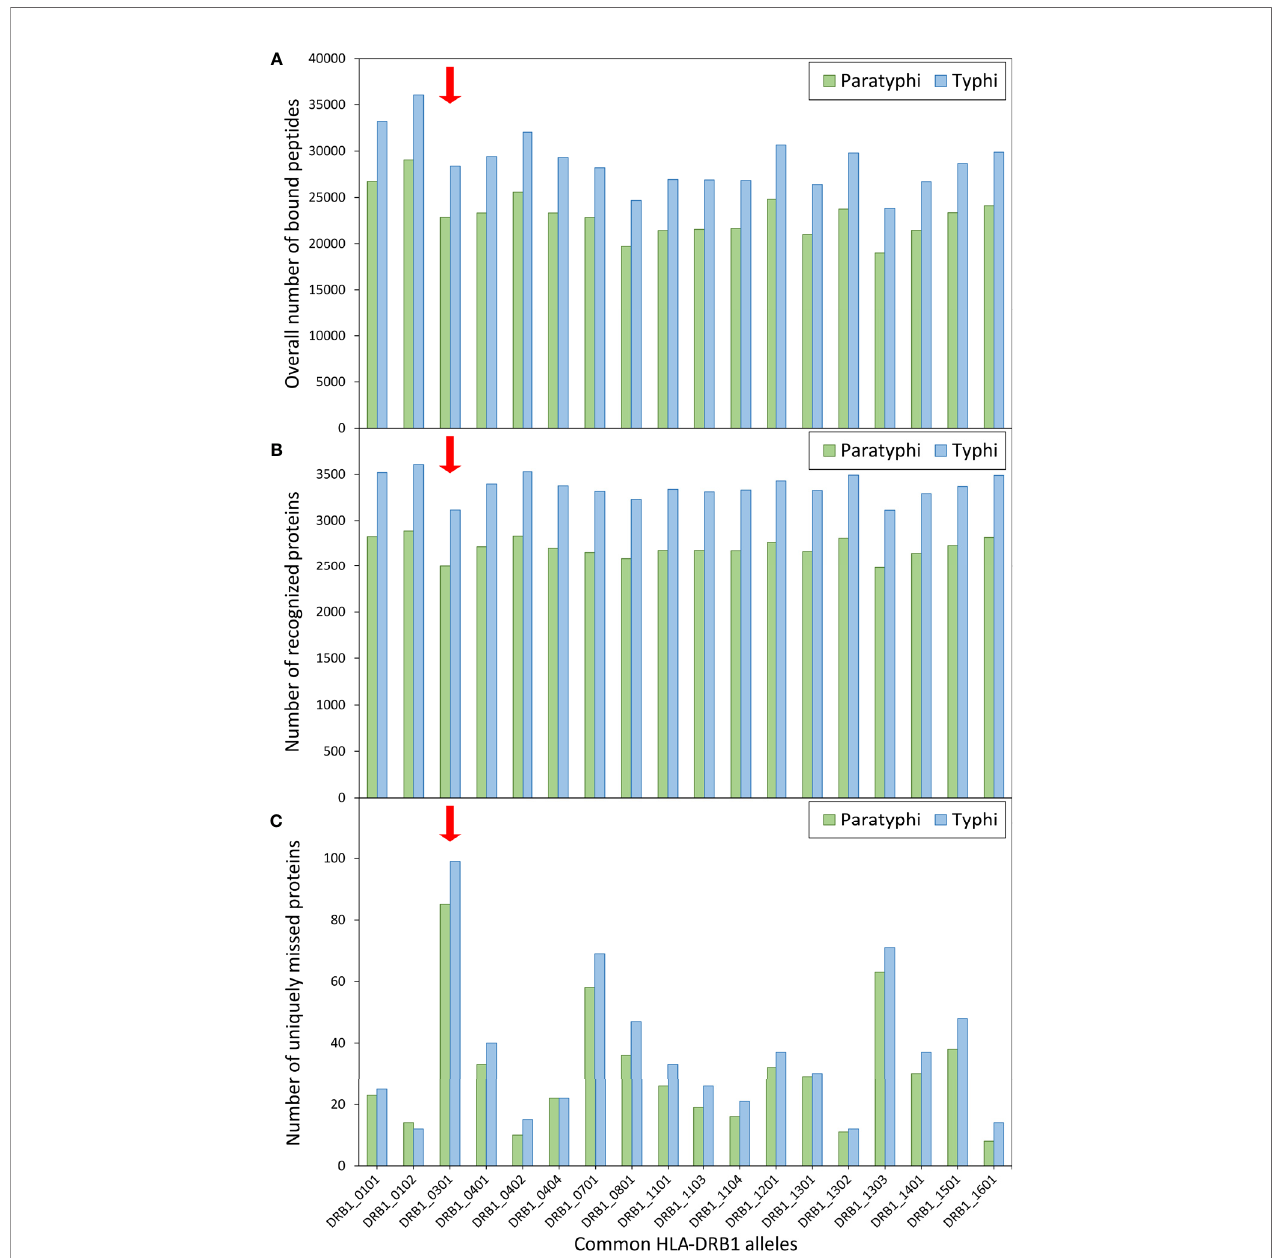
FIGURE 2 | Computationally predicted binding of common HLA-DRB1 variants to bacterial peptides. Binding prediction was performed for all HLA-DRB1 variants with allele frequency >1% in present-day Germany (n=18), using the full proteomes of both Salmonella enterica Paratyphi C (green bars) and S. Typhi (blue bars). For each DRB1 variant, (A) the overall number of bound peptides, (B) the total number of ‘ recognized ’ proteins (at least one peptide bound by a given DRB1 variant), and (C) the number of uniquely ‘ missed ’ proteins (recognized by all other variants) are